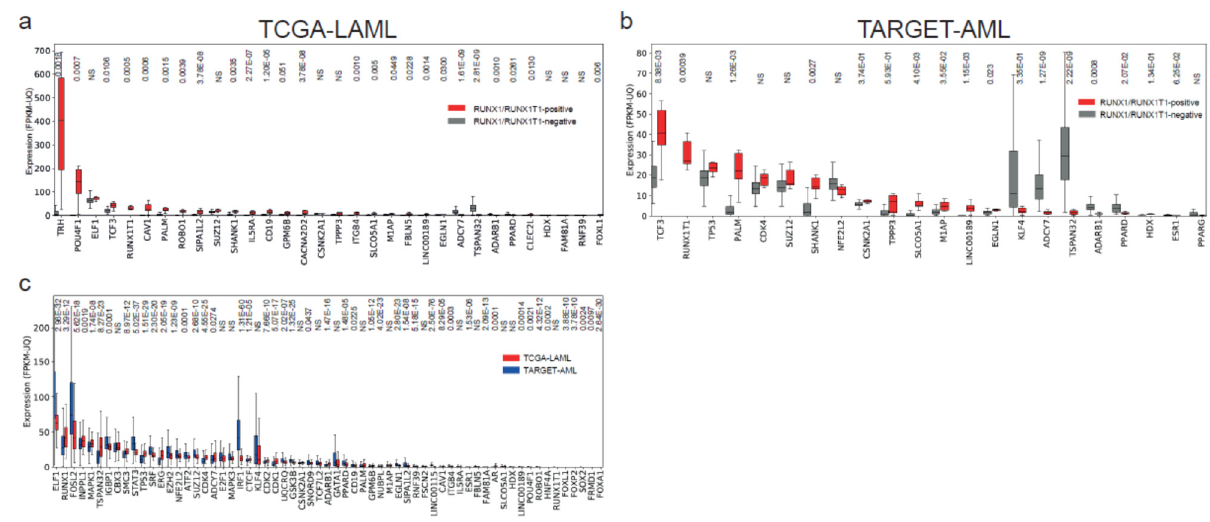
Figure 7. Expression levels of the top deregulated genes and their upstream regulators in RUNX1/RUNX1T1-positive and RUNX1/RUNX1T1-negative adult ( a ) or pediatric ( b ) AML patients. Data were extracted from the TCGA-LAML (adult AML) and TARGET-AML (pediatric AML) projects, respectively. Comparison of the expression levels between the top deregulated genes and their upstream regulators, between pediatric (TARGET-AML) and adult (TCGA-LAML) AML patients ( c ). The BH-adjusted p -values of all statistically signi fi cant di ff erences between di ff erent groups are depicted on top of each sub fi gure. NS, not-signi fi cant p -value ( p > 0.05).